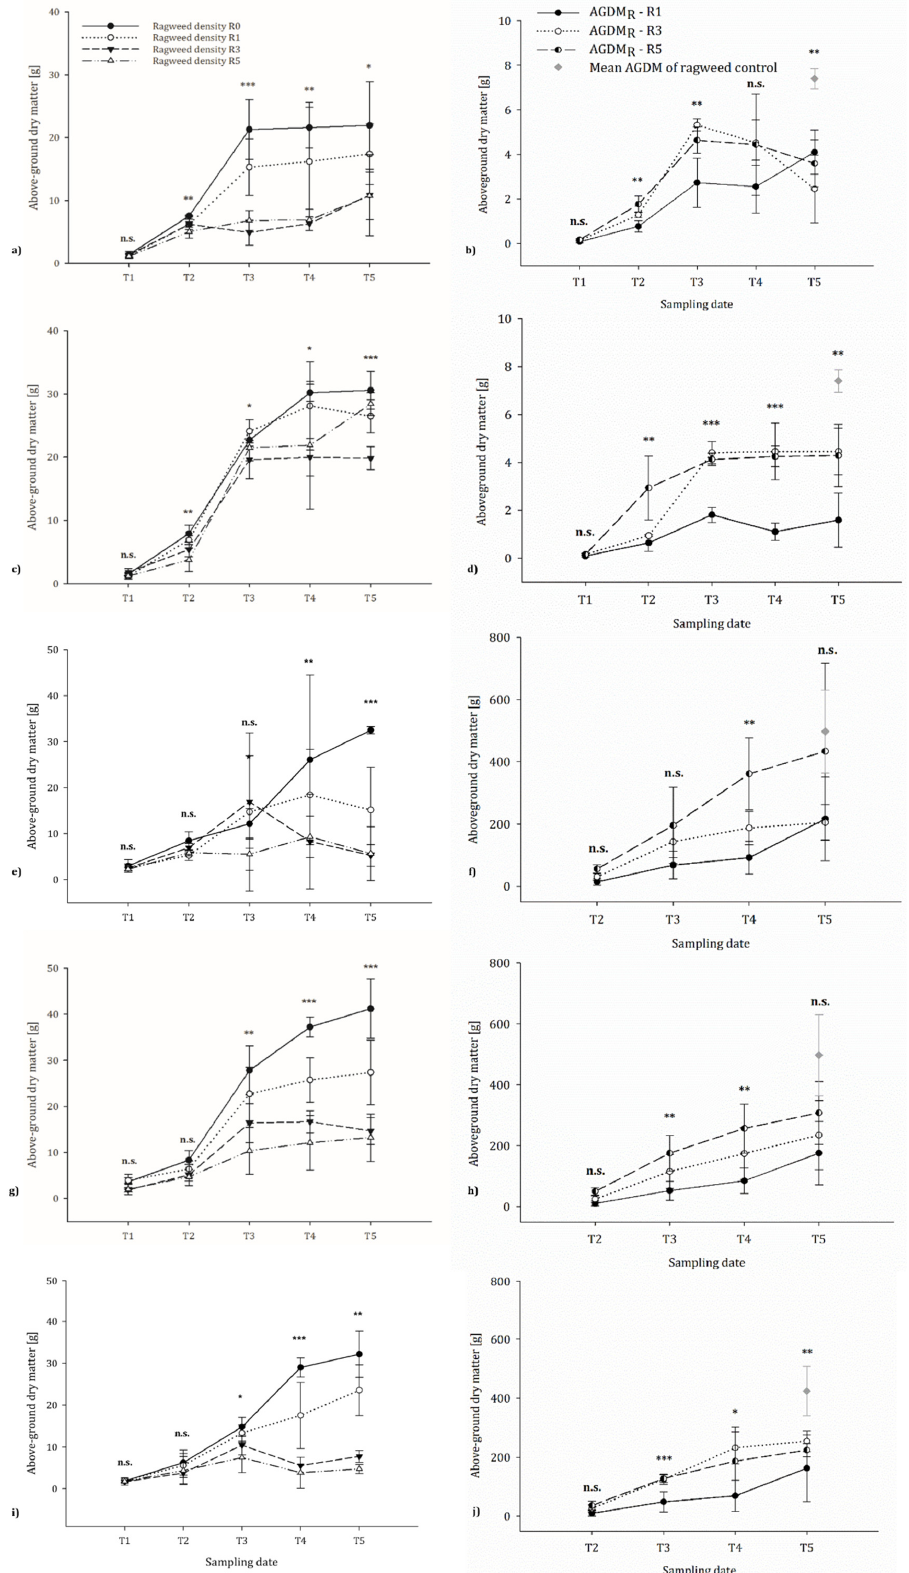
Figure 1. Above-ground dry matter (g) of soybean (left) and ragweed (right) of ( a , b ) Albenga (greenhouse trial, 2018), ( c , d ) ES Mentor (greenhouse trial, 2018), ( e , f ) Albenga (field trial, 2017), ( g , h ) ES Mentor (field trial, 2017), ( i , j ) Albenga (field trial, 2018), in the course of the trial period, with dependency on the ragweed density (0, 1, 3, 5 plants: R0, R1, R3, R5; n = 4; significance levels: * p < 0.05, ** p < 0.01, *** p <